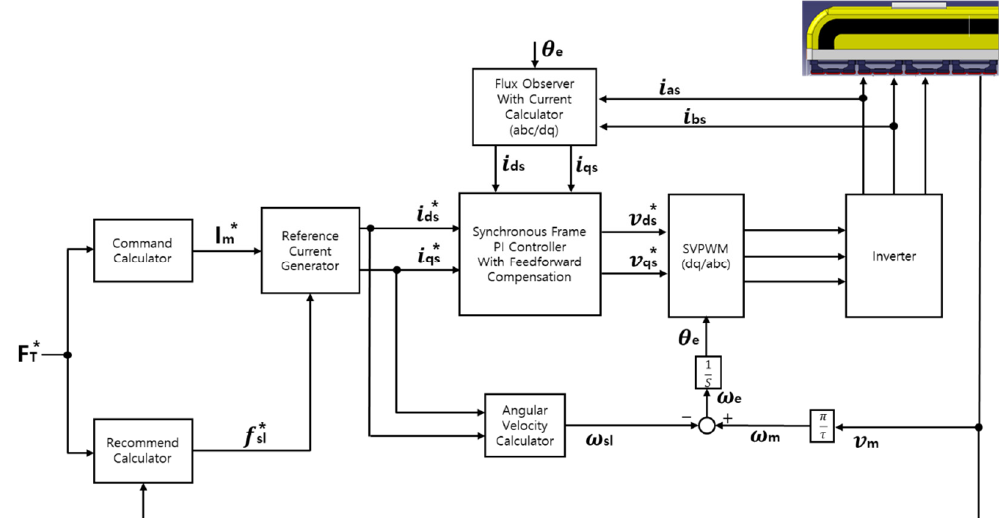
Figure 5. Control algorithm of proposed method .